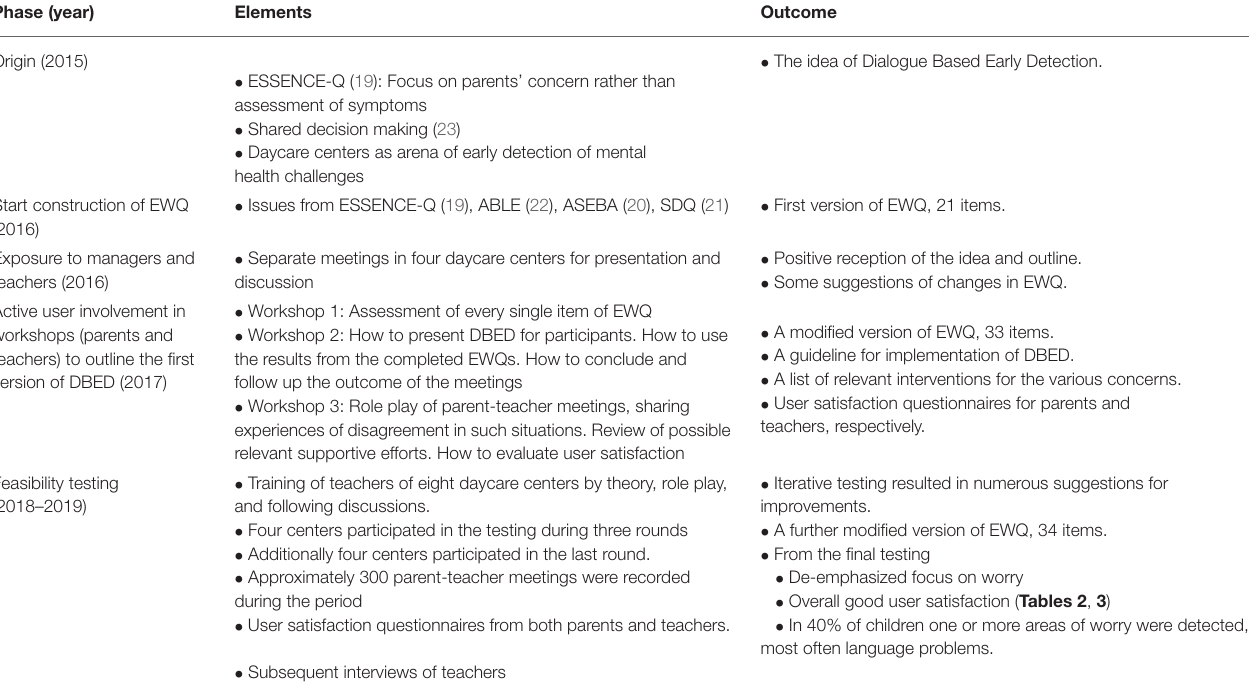
TABLE 1 | Development process of Dialogue Based Early